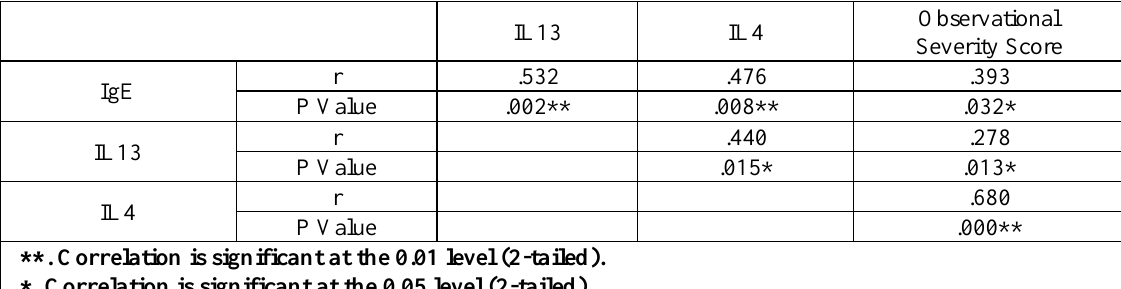
Table 6. Correlations between Observational severity score, IgE, IL-4 and IL-13 in all studied